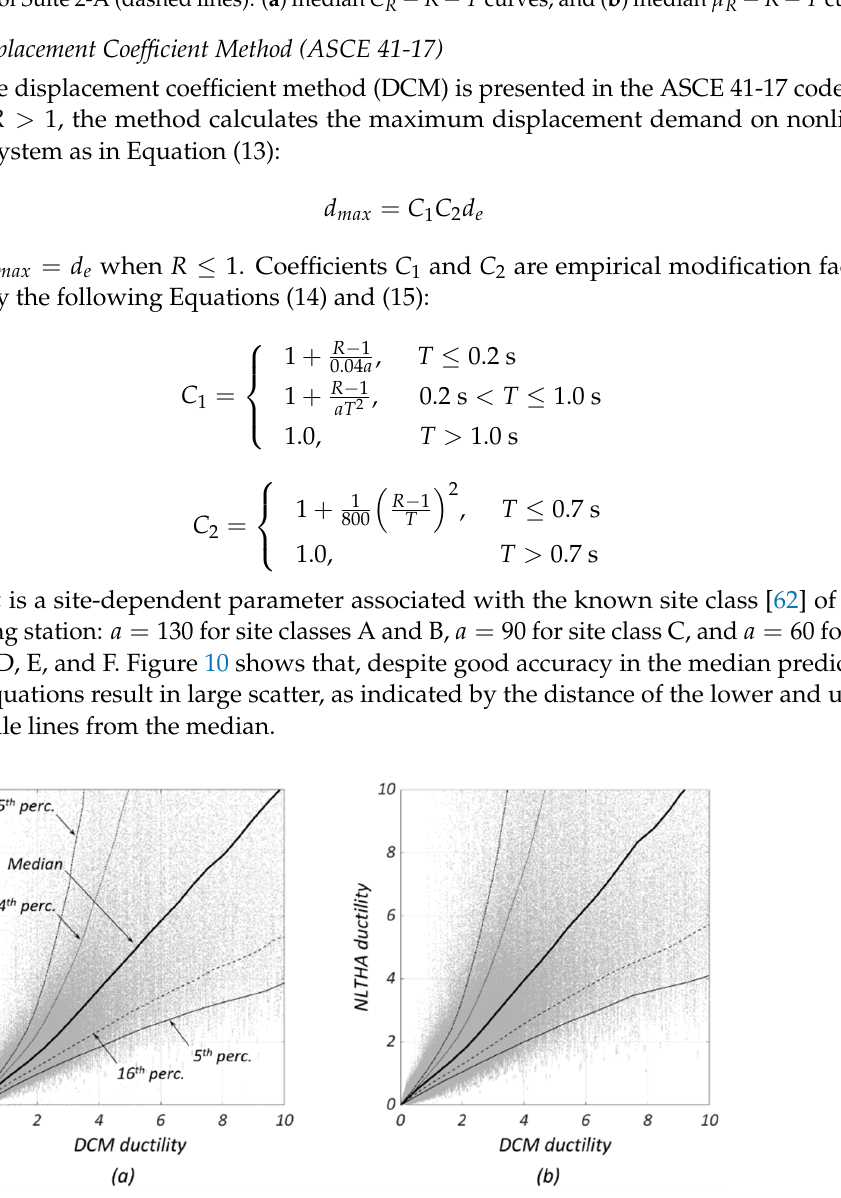
Figure 10. Comparison between ductility demands from the displacement coefficient method (DCM) by ASCE 41-17 and from NLTHA: ( a ) Suite 1-A, and ( b ) Suite 1-B.